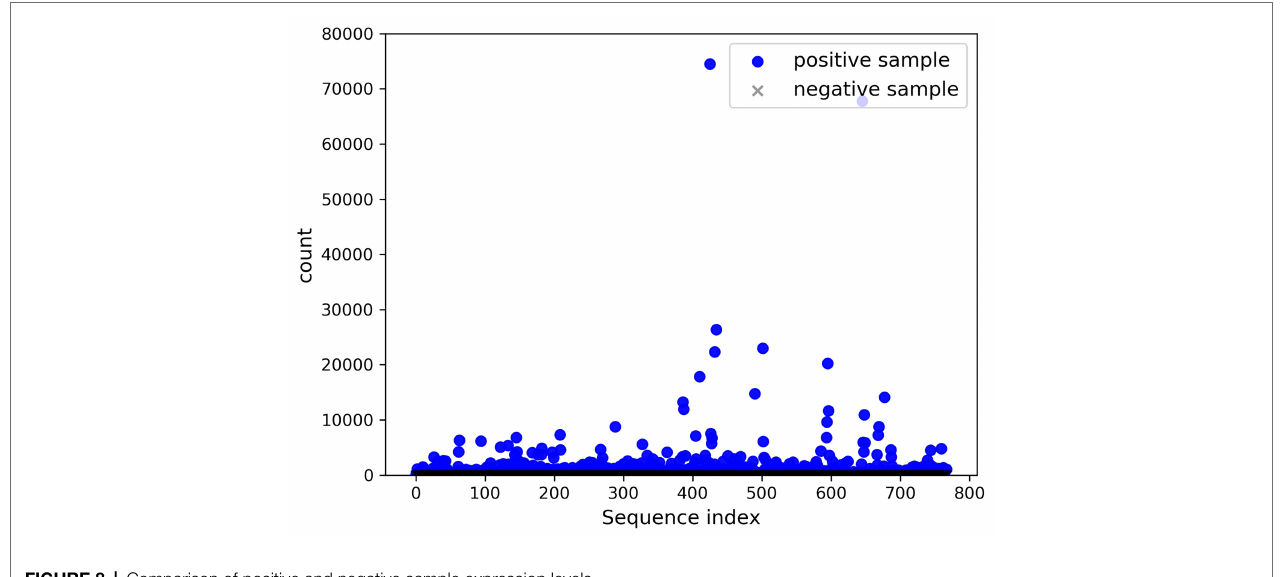
FIGURE 8 | Comparison of positive and negative sample expression